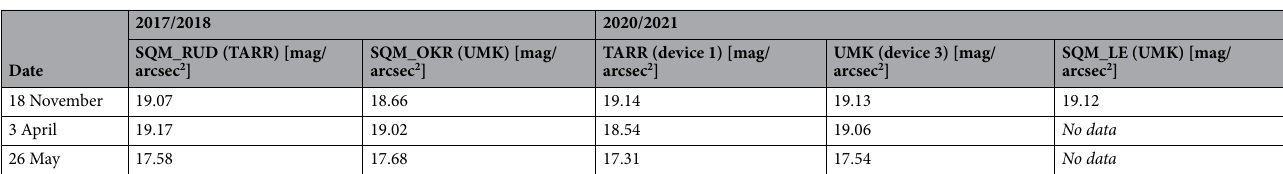
Table 2. Sample measurements from the 2017/2018 project and the new project